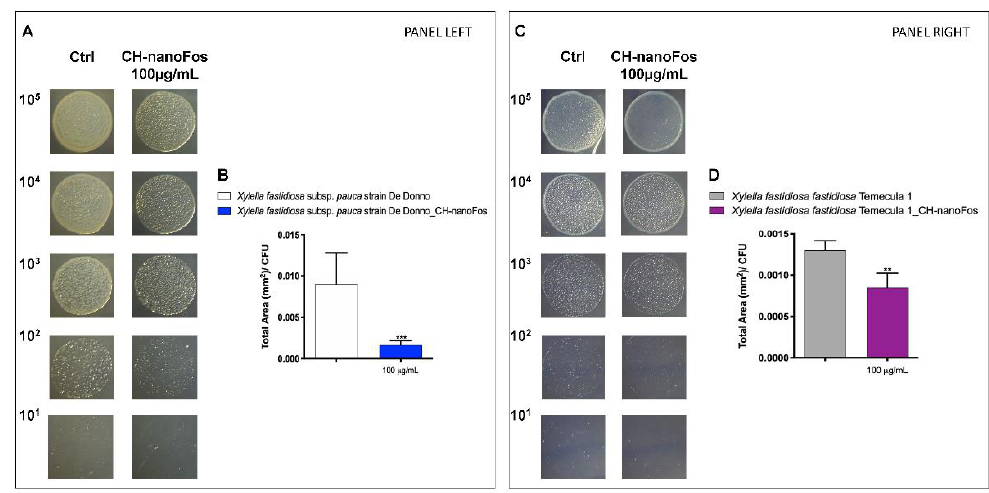
Figure 8. Bacteriostatic/bactericide effect evaluation on Xfp strain De Donno (left panel) and Xff strain Temecula1 (right panel). ( A,C ) 10 μL of decimal dilutions from 105 to 101 CFU mL −1 of Xfp strain De Donno and Xff strain Temecula1 were spotted on PD2 agar plates poisoned or not with CH-nanoFos (100 µg/mL, 10 µg/mL) and incubated at 28 °C ( B,D ). The total area and the number of bacterial colonies grown on 102 drops, represented as a ratio between total mass area and CFU grown were counted using ImageJ software. Data are expressed as means ± S.D. ( n = 8, experiment repeated 2 times with different inoculum; * p < 0.05 vs. Ctr).